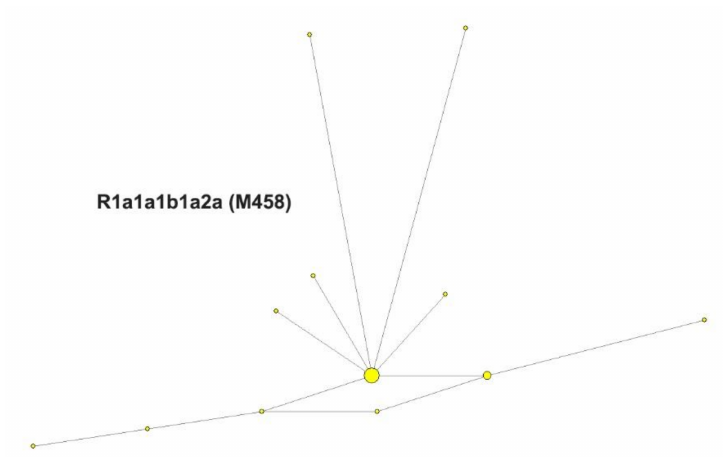
Figure 5. Median-joining network based on 24 Galiˇcnik YSTR haplotypes within the R1a1a (M198) haplogroup. The size of each circle corresponds to the number of individuals belonging to that haplotype. Yellow circles represent haplotypes identified in Galiˇcnik individuals. The lengths of the lines correspond to the number of mutational di ff erences between